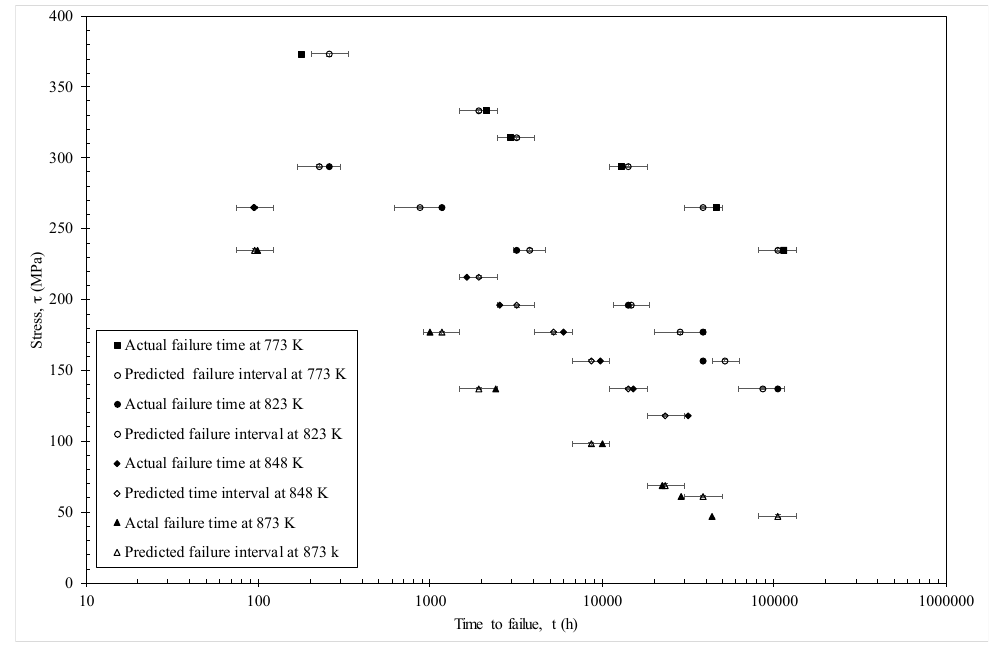
Figure 6. Actual failure times and predicted times interval obtained from the model given by Equation (19e). Materials 2017 , 10 , 1190